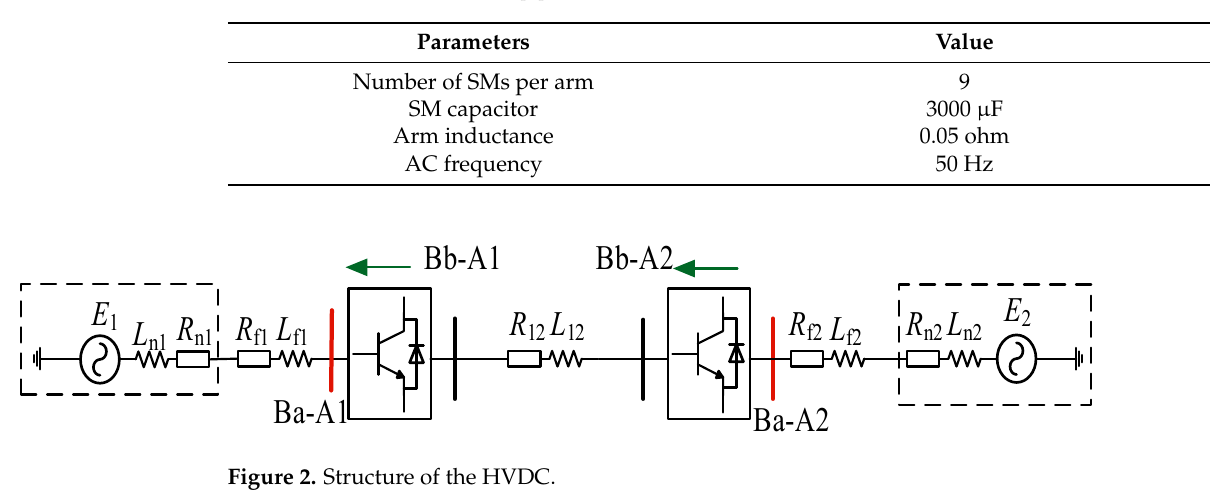
Table 2. Parameters of MMC [6].